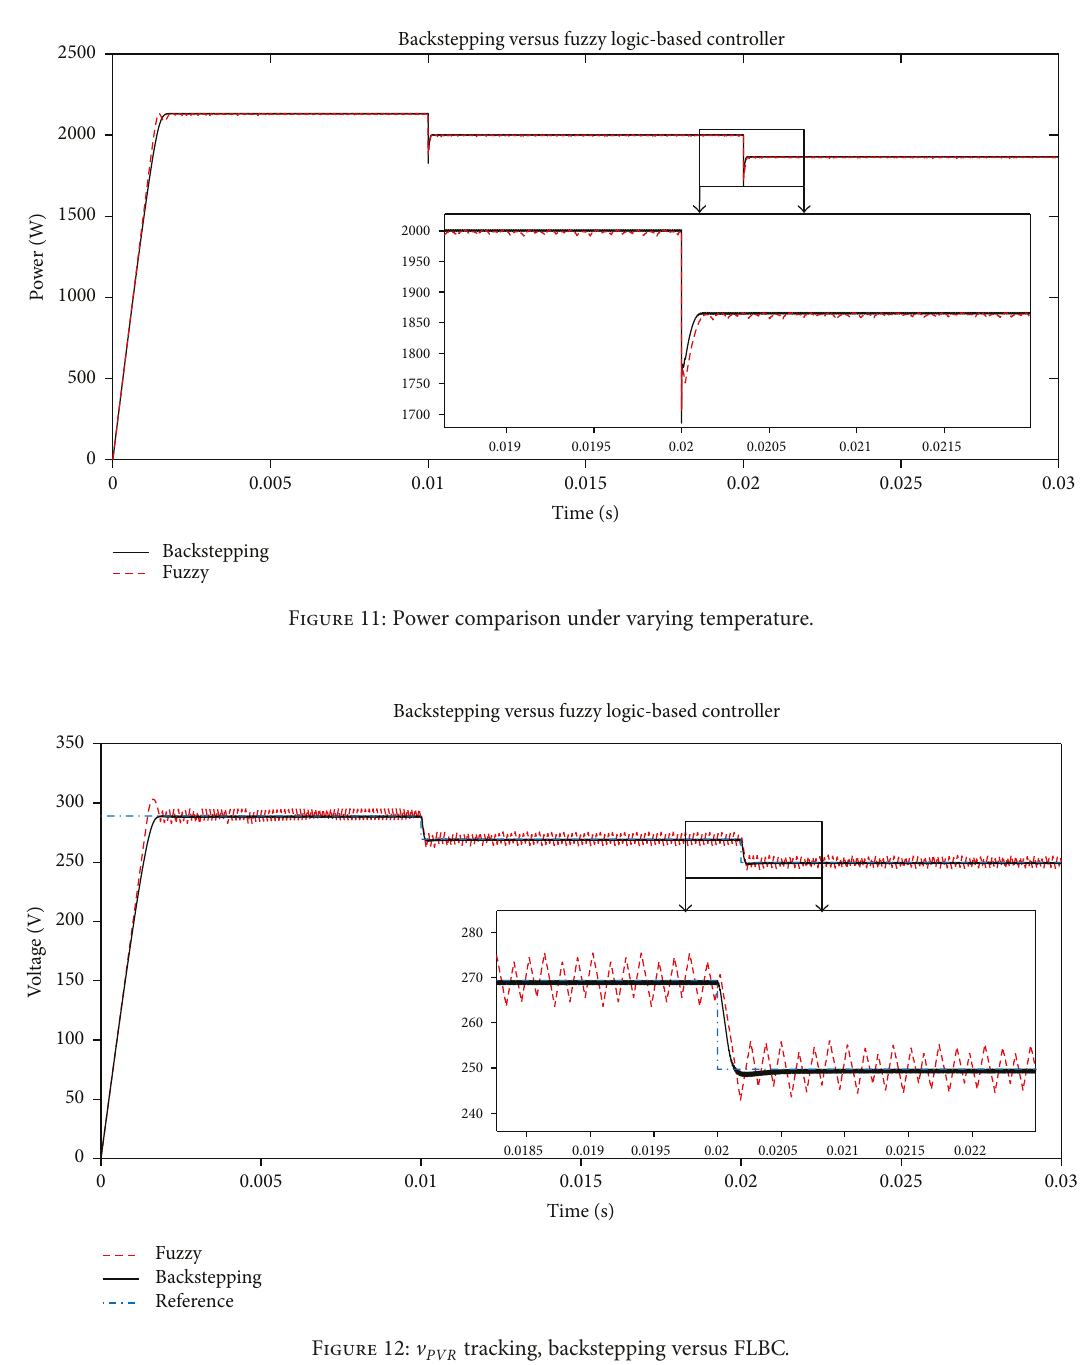
Figure 12: v PVR tracking, backstepping versus FLBC